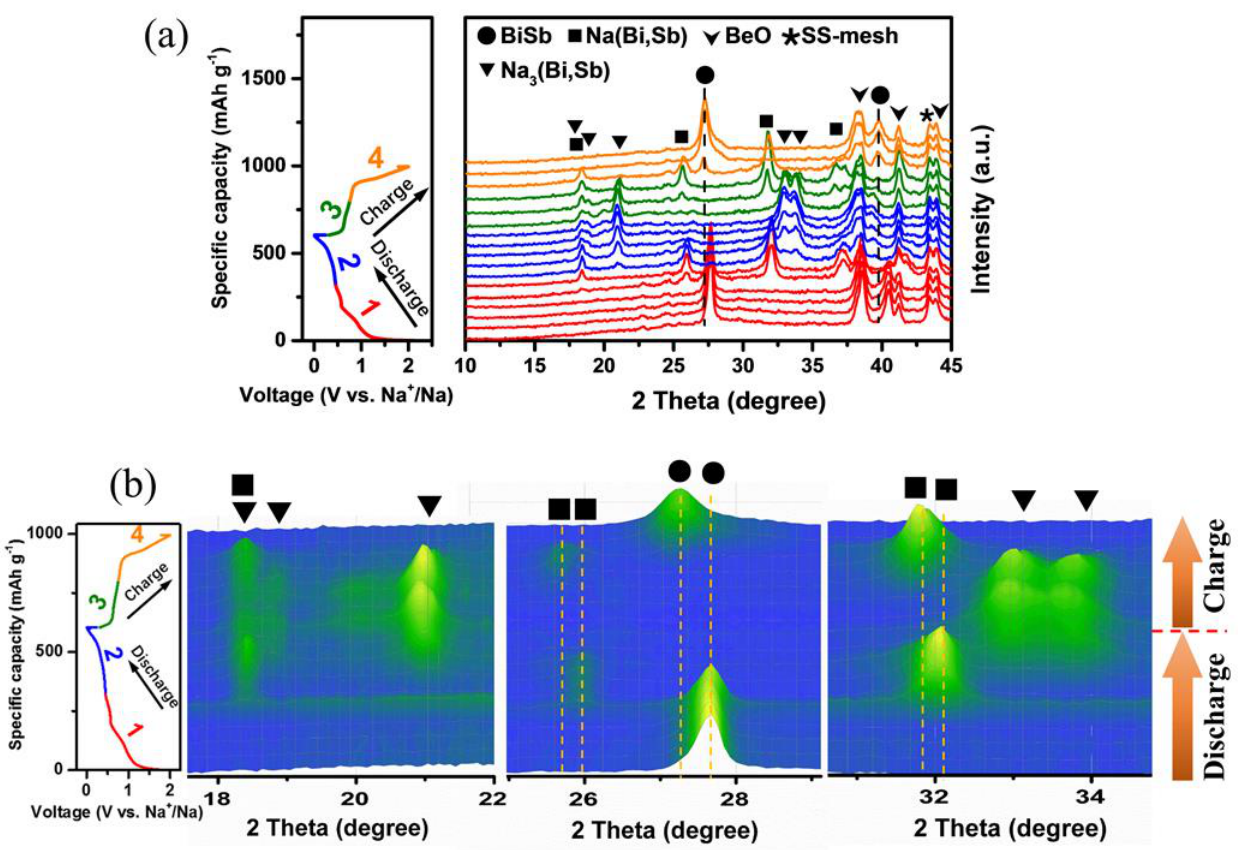
Figure 6. The ( a ) line plot and ( b ) contour plot for the in situ XRD patterns of the Bi 1 Sb 1 @C electrode obtained from the first cycle. The corresponding discharge/charge curves are tested at 0.05 A g −1 .